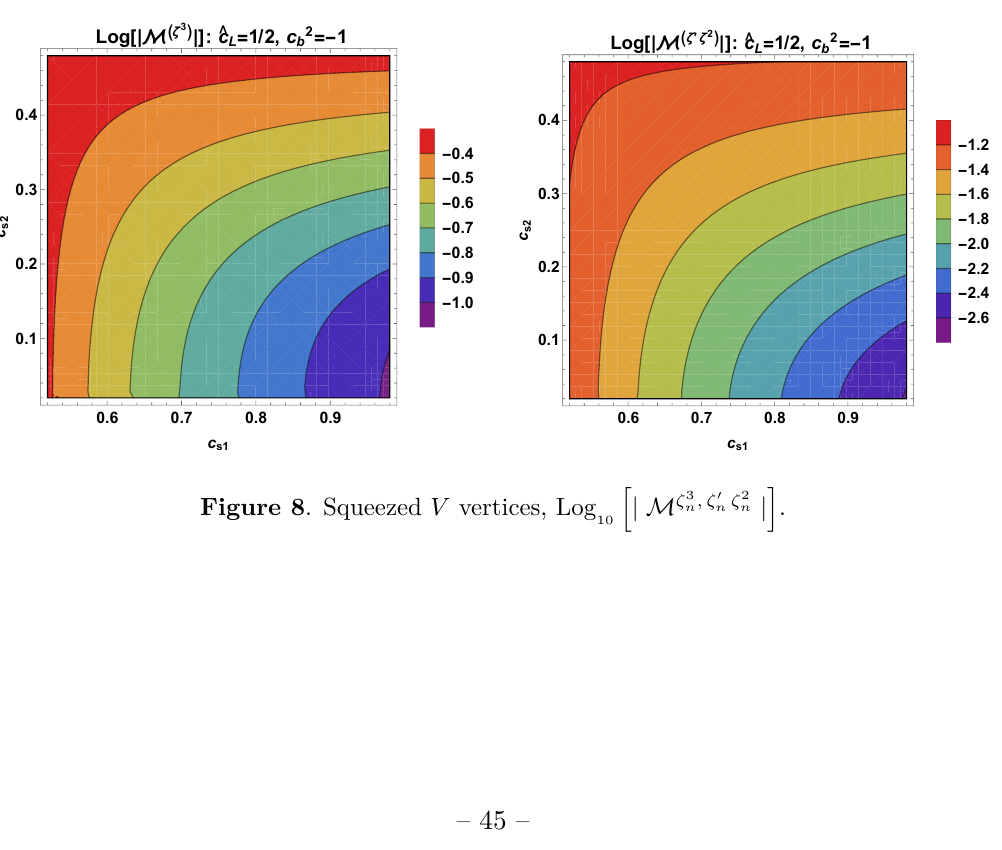
Figure 7 . Dominant squeezed SSS vertex: Log where M ˜ R 0 R 2 ∼ 10 2 .